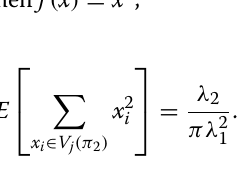
Table 1 Symbols and